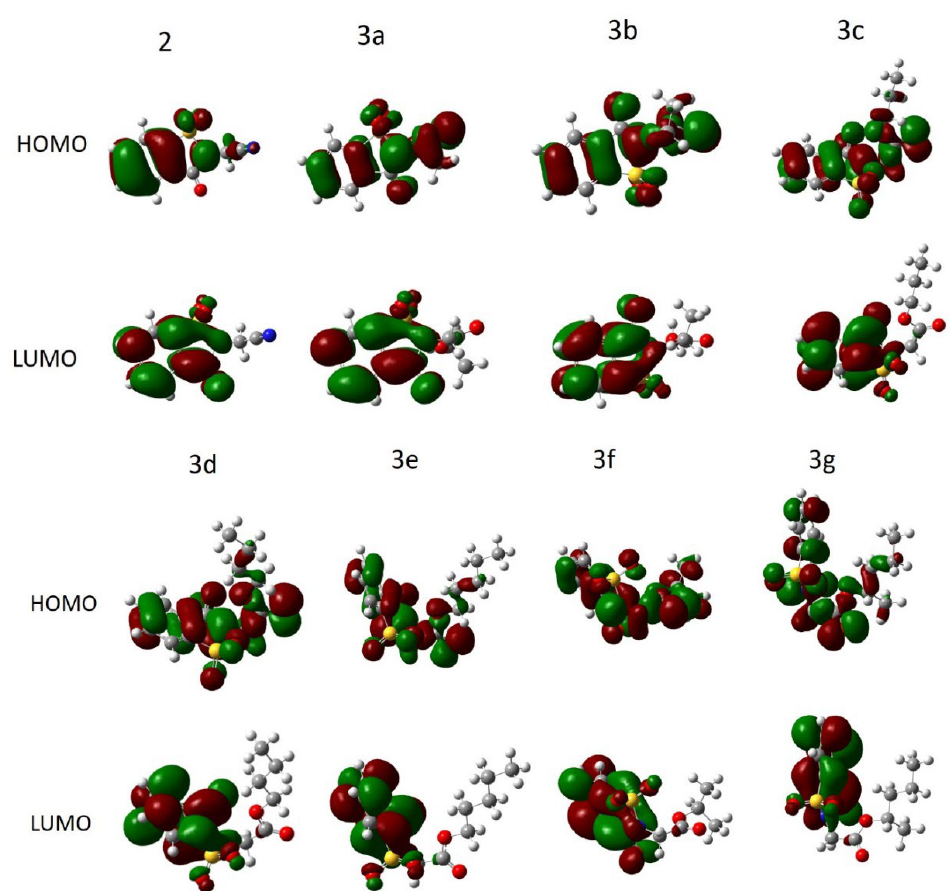
Figure 6. Spatial Electron Distribution of HOMO and LUMO of sultams 2 , 3a – g.